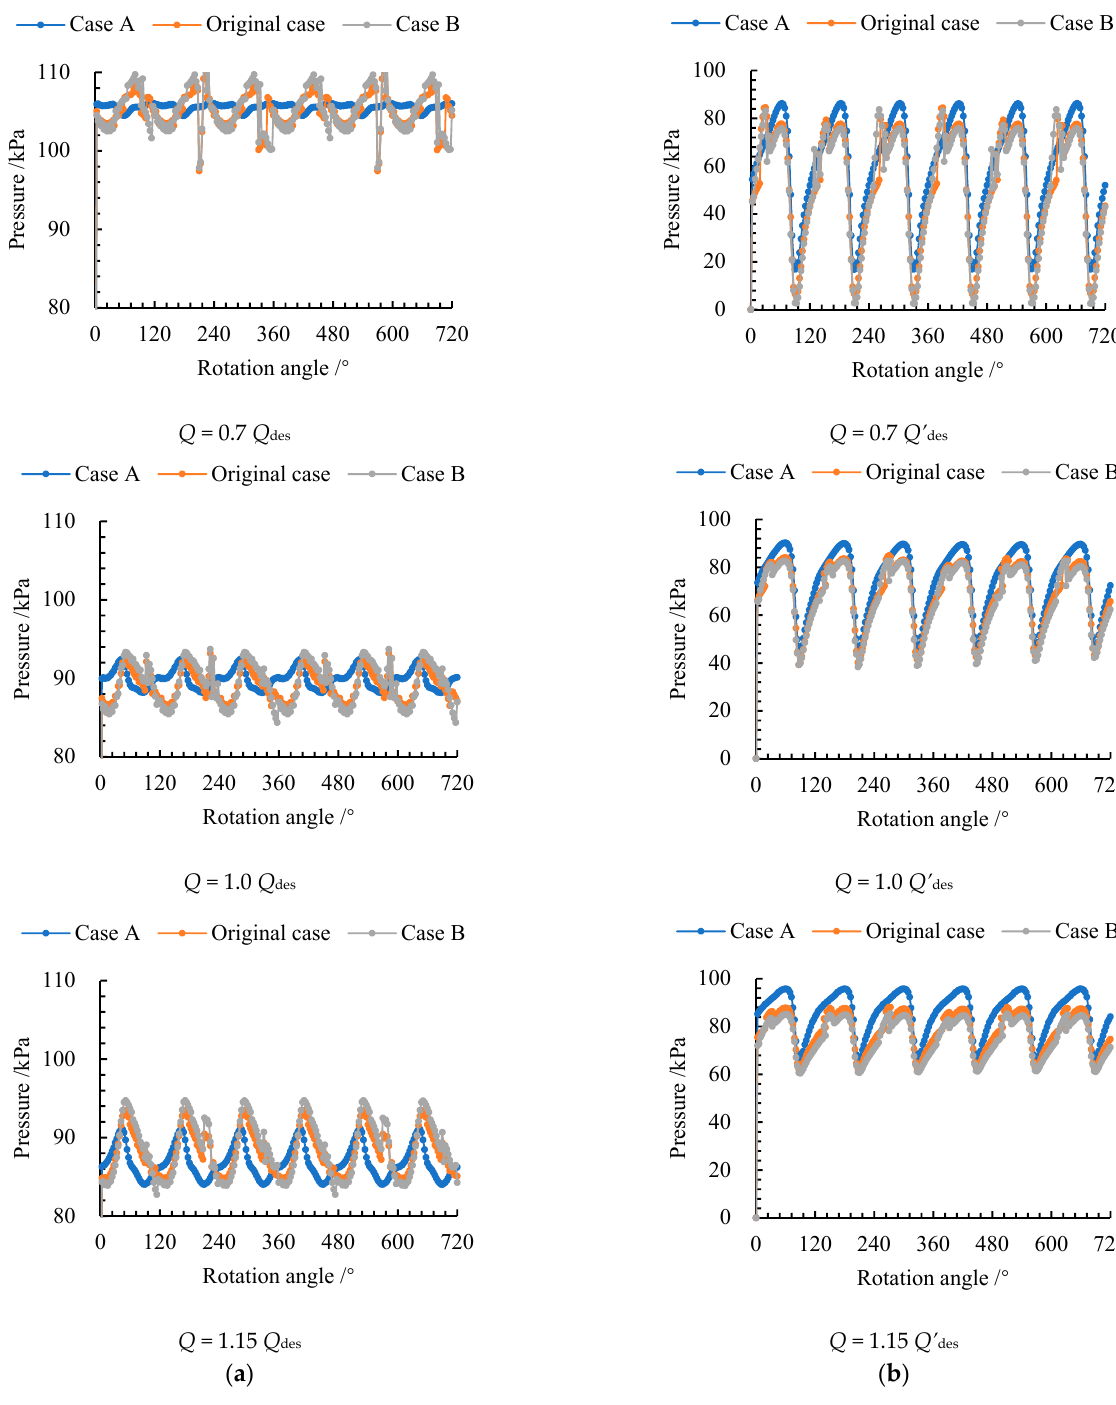
Figure 19. The time domain of pressure signal on B1 of three cases under ( a ) forward and ( b ) reverse conditions.